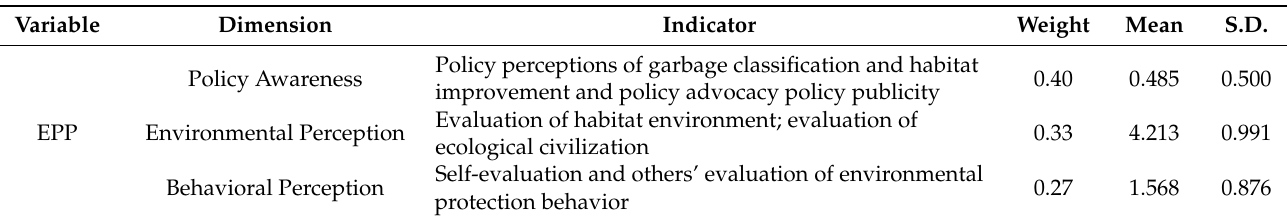
Table 3. Intermediary variable indicator and